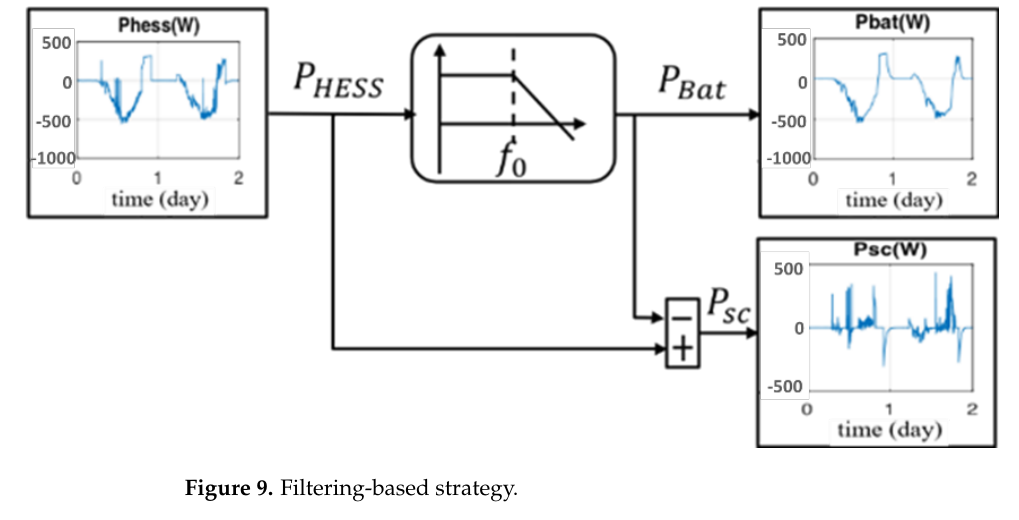
Figure 9. Filtering-based strategy.